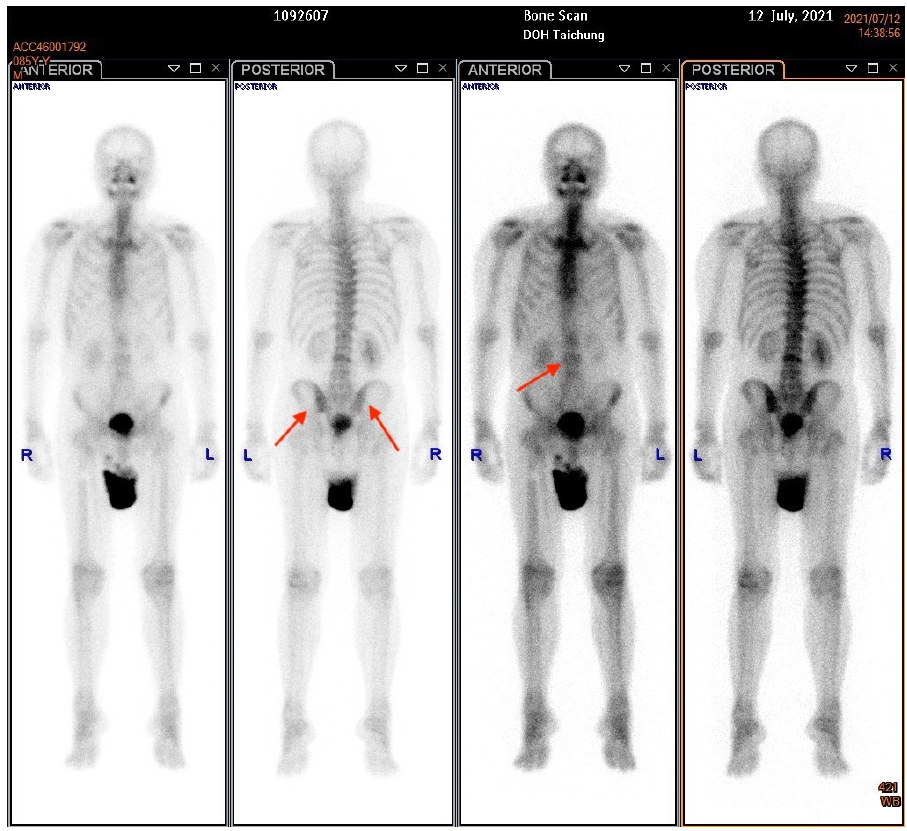
Figure 2. A bone scan demonstrated multiple boney metastases over the L -spine and pelvic wing. The arrows indicate the boney metastasis sites.